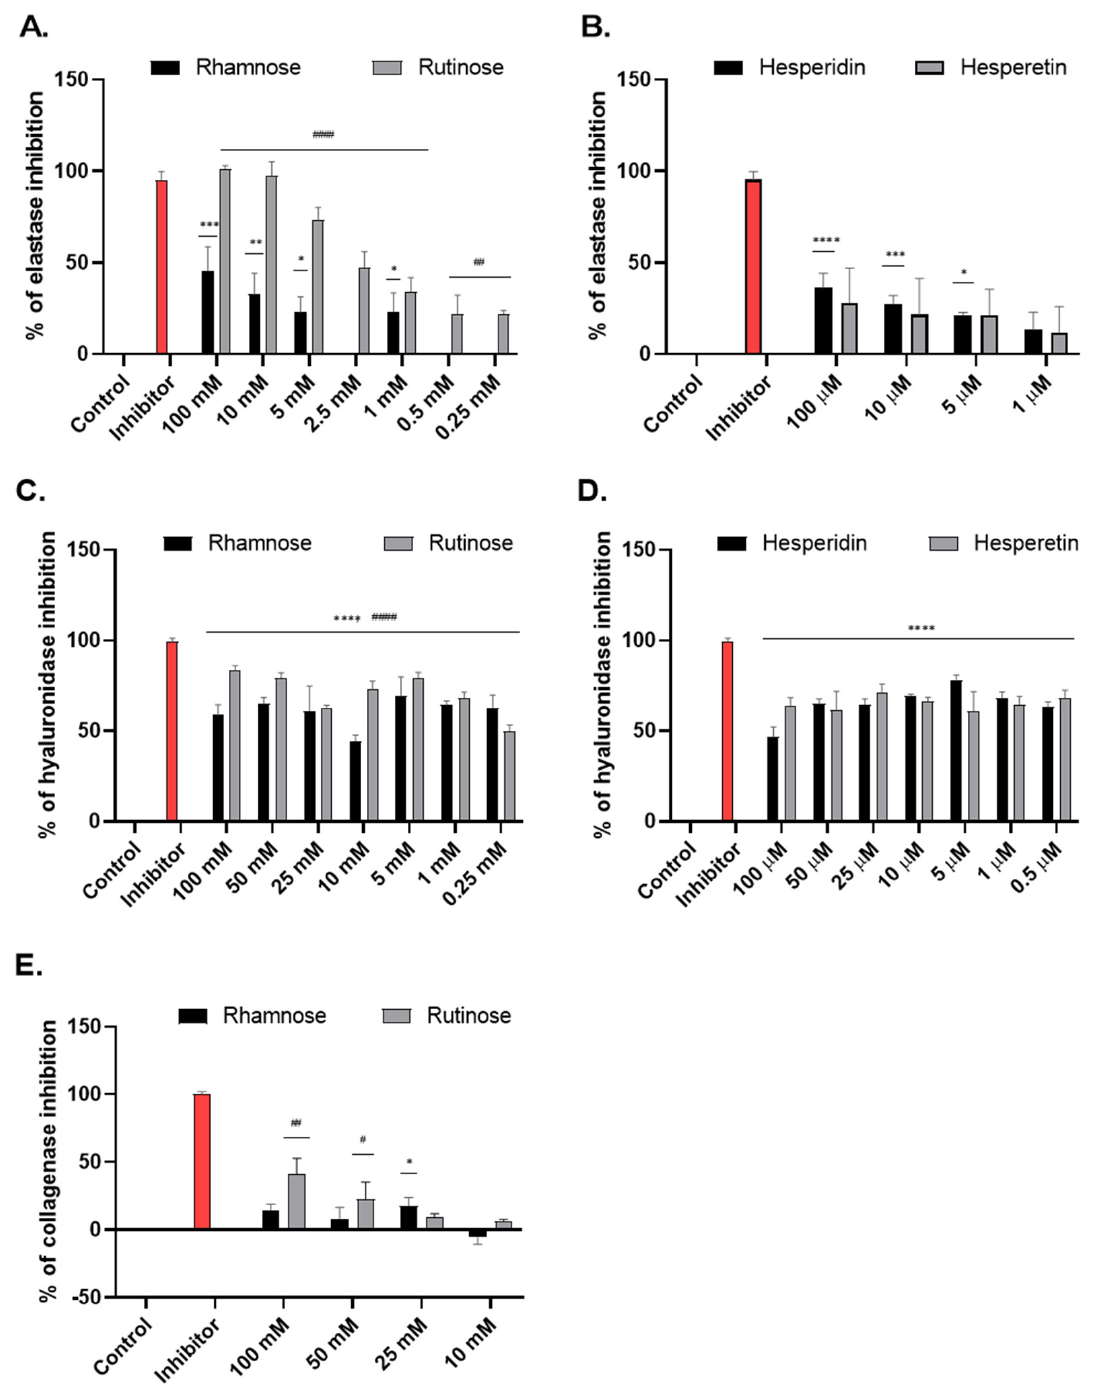
Figure 2. The effect of rhamnose, rutinose, hesperetin, and hesperidin on the pure enzymes: elastase ( A , B ), hyaluronidase ( C , D ), and collagenase I ( E ) activity using tube tests. Oleanolic acid (1.46 mg/mL) was used as the inhibitor of elastase (red color), sodium aurothiomalate (2.8 mg/mL) was used as the inhibitor of hyaluronidase (red color) and 1,10-phenanthroline (1 M) was used as the inhibitor of collagenase (red color). The results are expressed as an average of 3 measurements. * p < 0.05; ** p < 0.01; *** p < 0.001; **** p < 0.0001 were considered significant compared to control C. # p < 0.05; ## p < 0.01; #### p < 0.0001 were considered significant compared to control (for rutinose). (One-way ANOVA; Dunnett’s multiple comparisons tests were performed using GraphPad Prism).